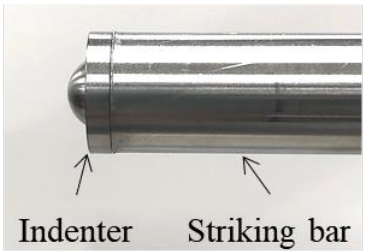
Fig. 2. Photograph of the indenter at the tip of the striking